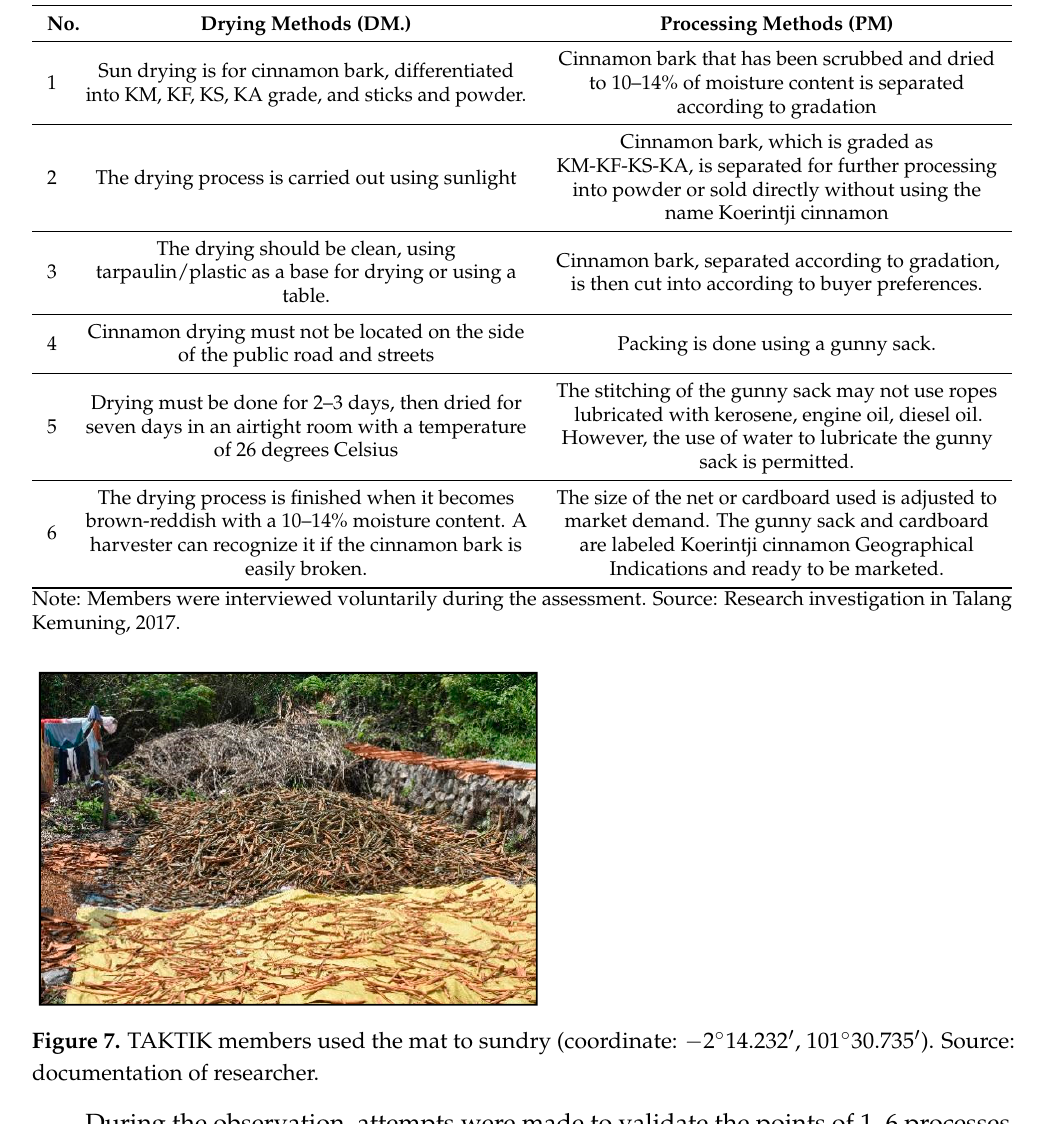
Table 3. Drying and processing methods for cinnamon based on the handbook of requirements for the GI for Koerintji Cinnamon, p. 12.